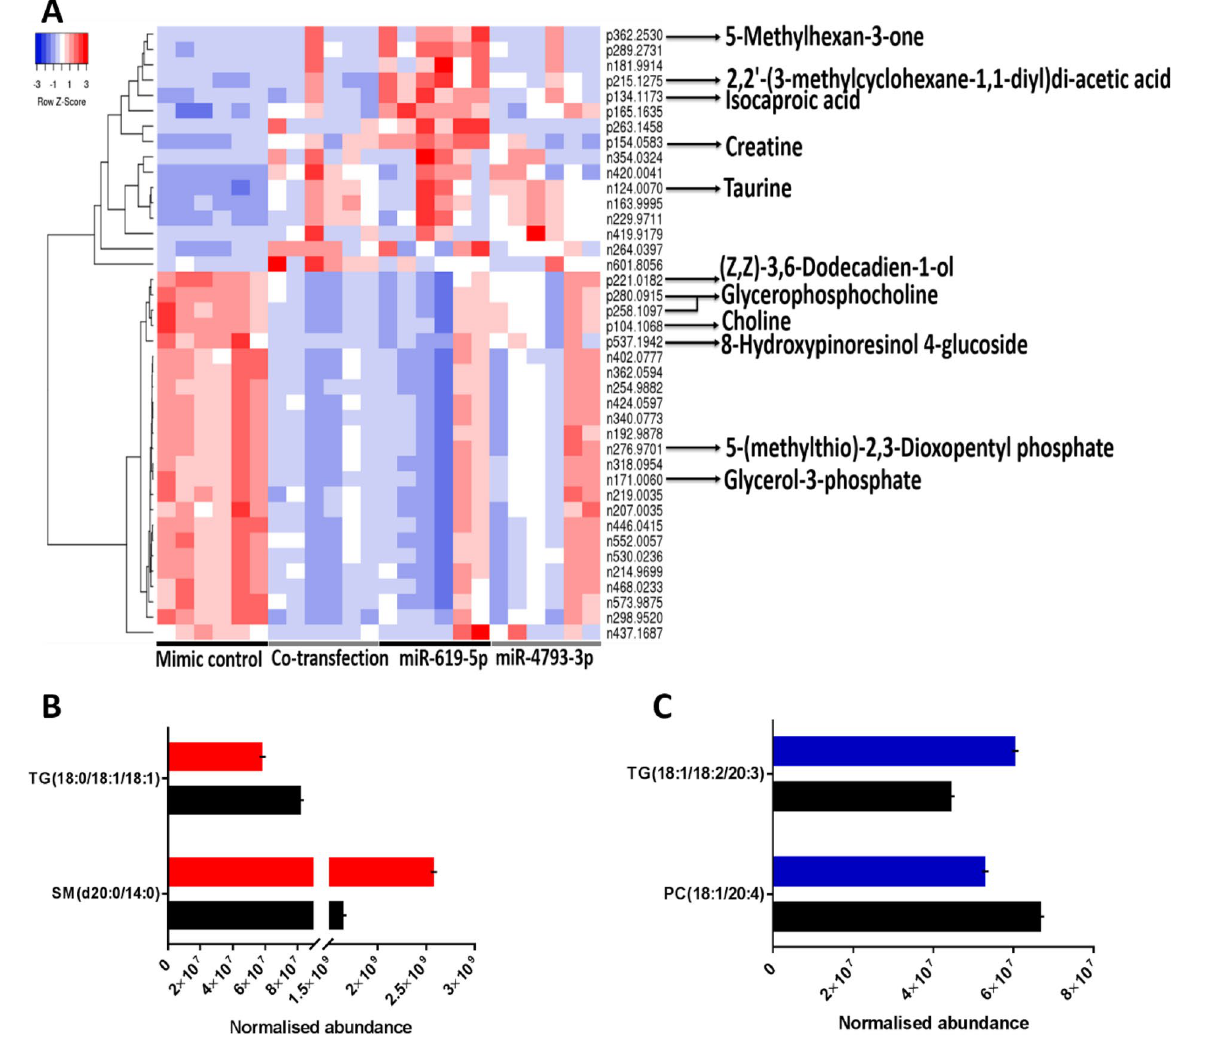
Figure 4. Global metabolic alterations following miR-619-5p and miR-4793-3p overexpression in GBM cells. ( A ) Hierarchical cluster analysis of differential metabolites in miR-619-5p, miR-4793-3p or miR-619-5p/ miR- 4793-3p co-transfections relative to non-targeting control (NT). Shades of blue and red represent a decreased or increased abundance, respectively. Average linkage was applied as a clustering method, and the Spearman rank correlation was used as a distance measurement method. Abundance levels of significantly altered lipid species following ( B ) miR-619-5p and ( C ) miR-4793-3p transfections. Values are shown as mean of six biological repeats ± S.E.M. PC phosphatidylcholine, SM sphingomyelin, TG Five metabolites were identified from Cluster 1, and seven were identified from Cluster 2 (Fig. 4A). Such metabolites showed an average fold change of 2 between the transfection conditions. Each peak had a unique identification, except for glycerophosphocholine, which had two corresponding peaks in Cluster 2. Additionally, taurine was the only identifiable overlapping metabolite that contributed to the distinctions between NT and miR-4793-3p and between NT and miR-619-5p/miR-4793-3p co-transfections. We subsequently performed metabolic pathway enrichment analysis on those metabolites. Based on the analysis from MetaboAnalyst 3.0, the altered metabolites were mapped to nine key metabolic pathways (Table 3). Glycerophospholipid was the only significantly enriched pathway for choline, glycerophosphocholine and glycerol-3-phosphate. Lipidomics analysis was also performed to compare lipid profiles of the cells overexpressing miR-619-5p, miR-4793-3p or both miRNAs were compared to NT. While 6201 and 3577 lipid features were detected in positive and negative ionisation modes, respectively; a total of 382 lipid species were putatively identified using LipidSearch. Different levels of confidence in identification were assigned for the lipids based on class and fatty acid structure. Four lipids were identified as significantly altered between the different transfection conditions (Fig. 4B,C). The contents of the triglyceride species [TG (18:0/18:1/18:1)] were 1.4 fold lower in GBM cells over- expressing miR-619-5p compared to the control cells, while triglyceride species [TG (18:1/18:2/20:3)] were 1.3 folds higher in GBM cells overexpressing miR-4793-3p compared to the control cells transfected with NT. The phosphatidylcholine [PC (18:1/20:4)] was 1.4 folds lower in miR-4793-3p than in NT. Finally, the sphingomyelin